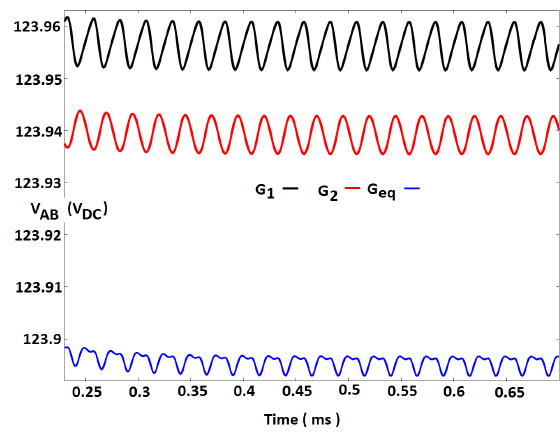
= 40 KHz, F s = 26 KHz. 2 1